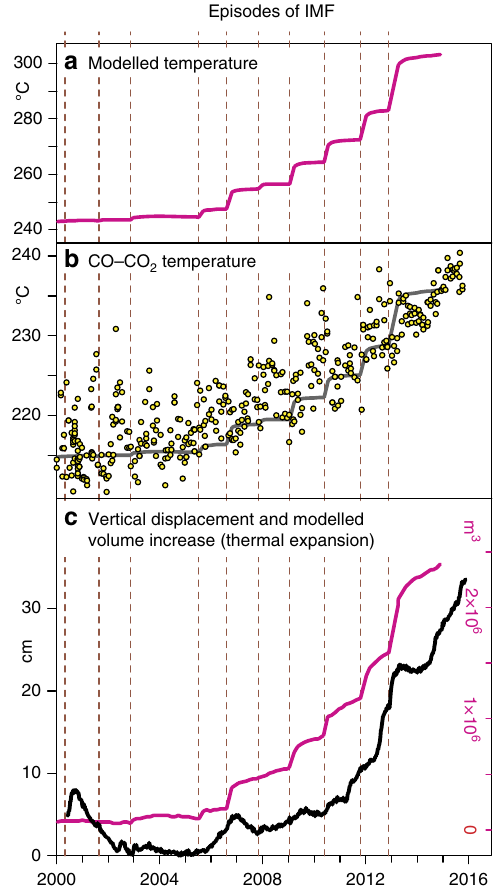
Figure 5 | Observations and modelled data for the current period of unrest of CFc. ( a ) Average temperature obtained by the model (in Simulation 2) for the central deeper zone of the computational domain. ( b ) Temperatures computed using the CO-CO 2 geothermometer at Solfatara fumaroles 14 compared with modelled temperatures (gray